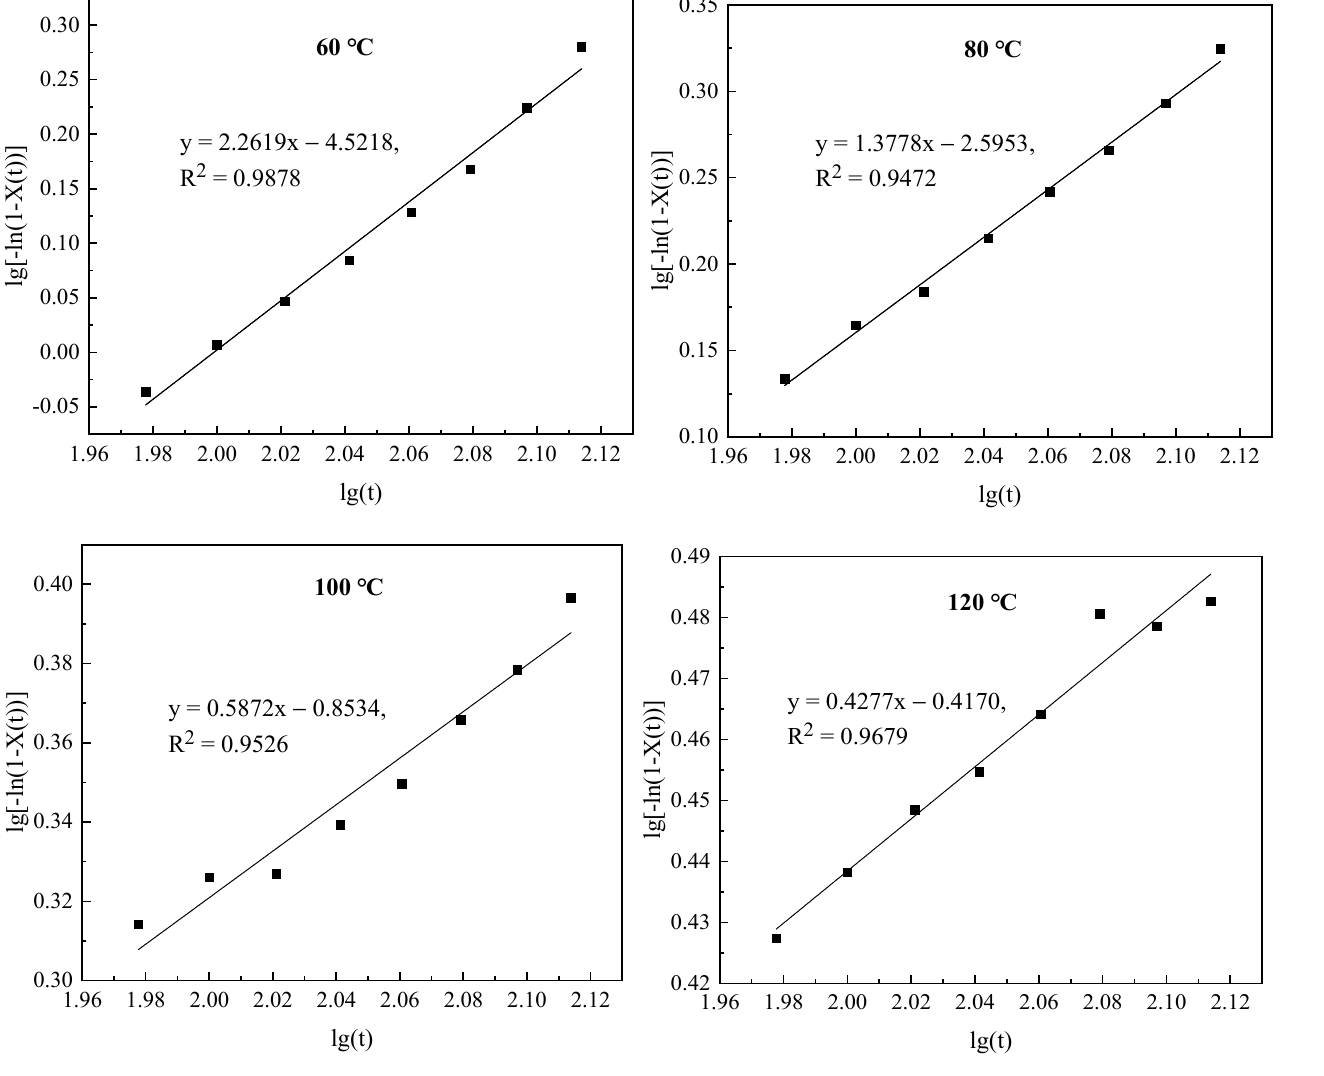
Figure 7. Relationship between lg[ − ln(1 − X(t))] and lgt at different precipitation temperatures. The kinetic parameters at different temperatures are arranged as shown in Table 6. It can be seen that the crystallization rate constant k of vanadium precipitation reaction in-